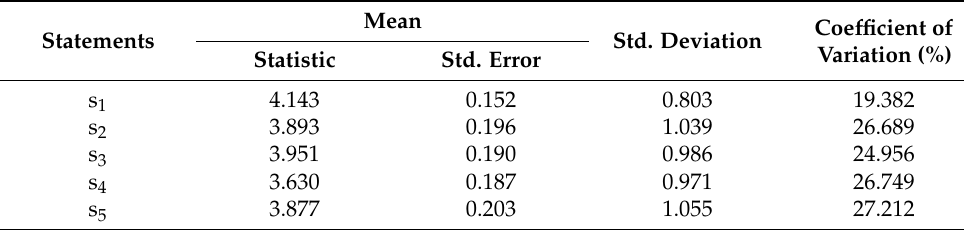
Table 9. Descriptive statistics for a group of suppliers.